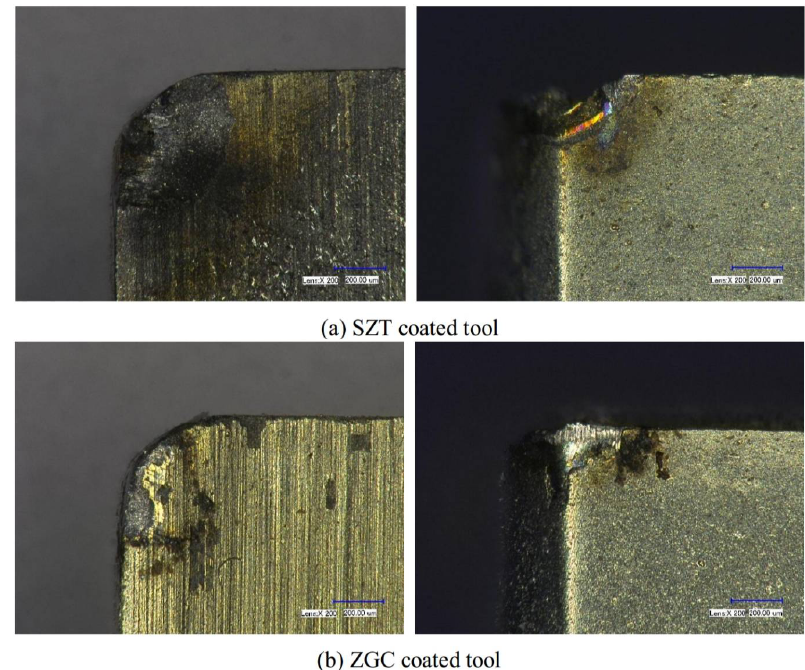
Figure 10. Wear morphology of rake face and flank face at a cutting speed of 200 m/min.